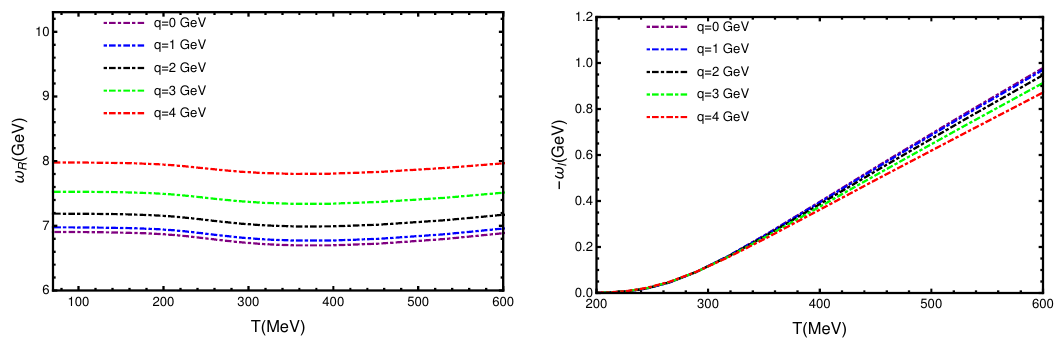
Figure 8 . Numerical results for the quasinormal modes of the bottomonium in the longitudinal direction as function of the